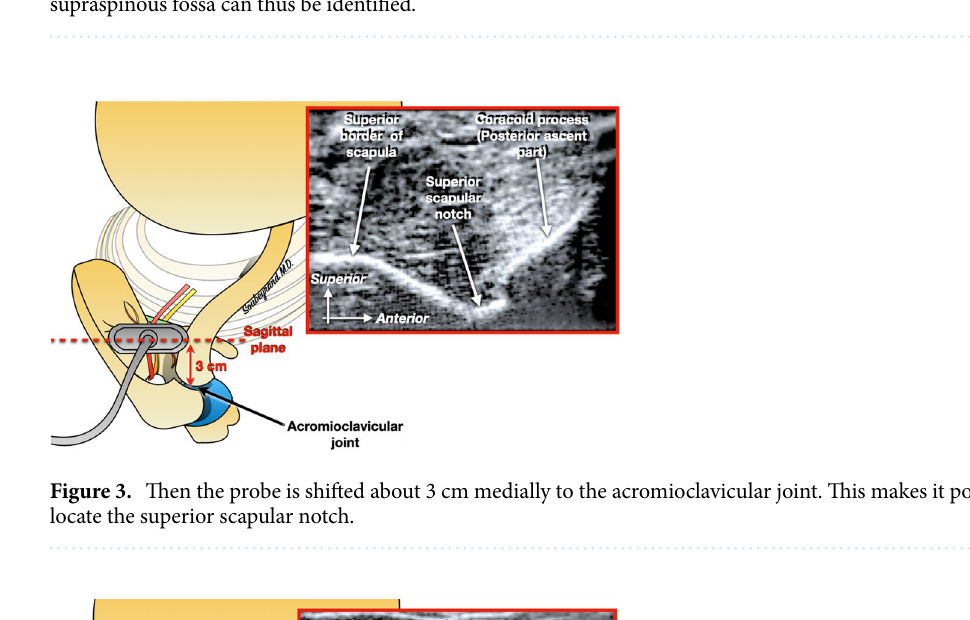
Figure 2. The ultrasound probe is positioned in the sagittal plane, just behind the acromioclavicular joint. The supraspinous fossa can thus be identified.